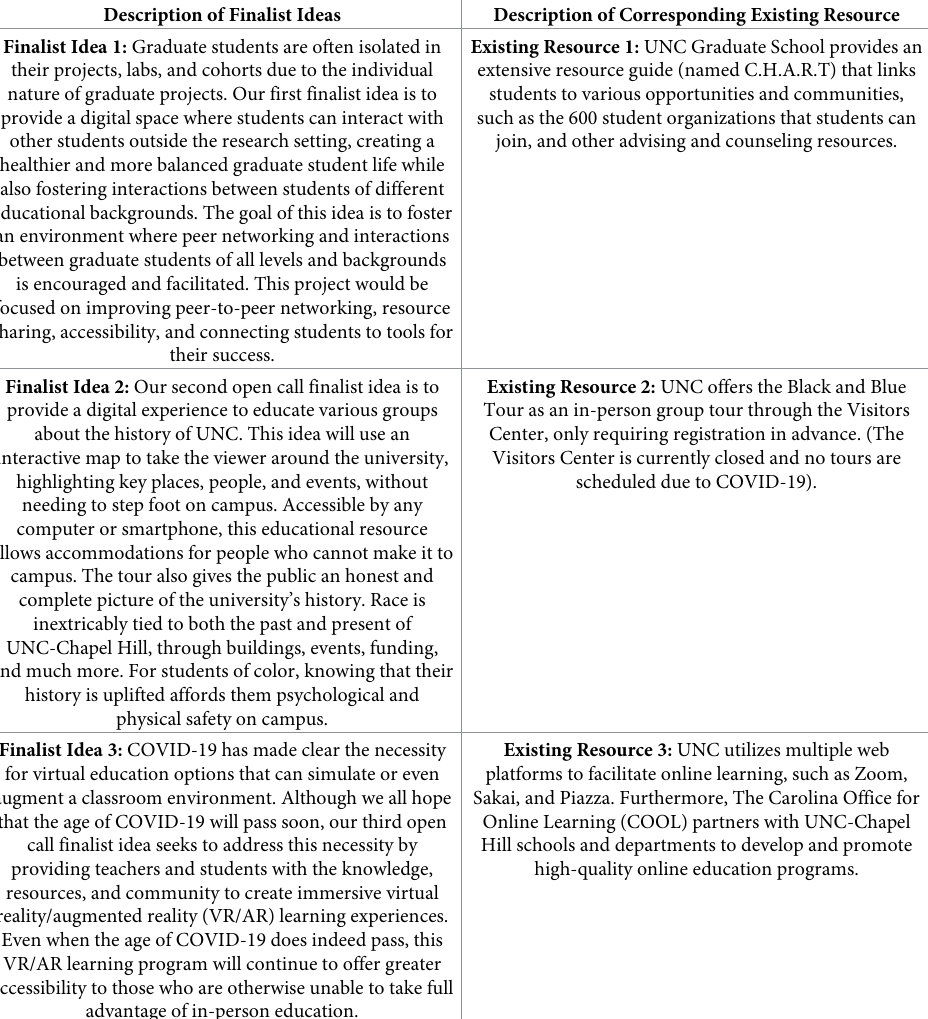
Table 1. Description of finalist ideas and corresponding existing resources at UNC, as presented to survey